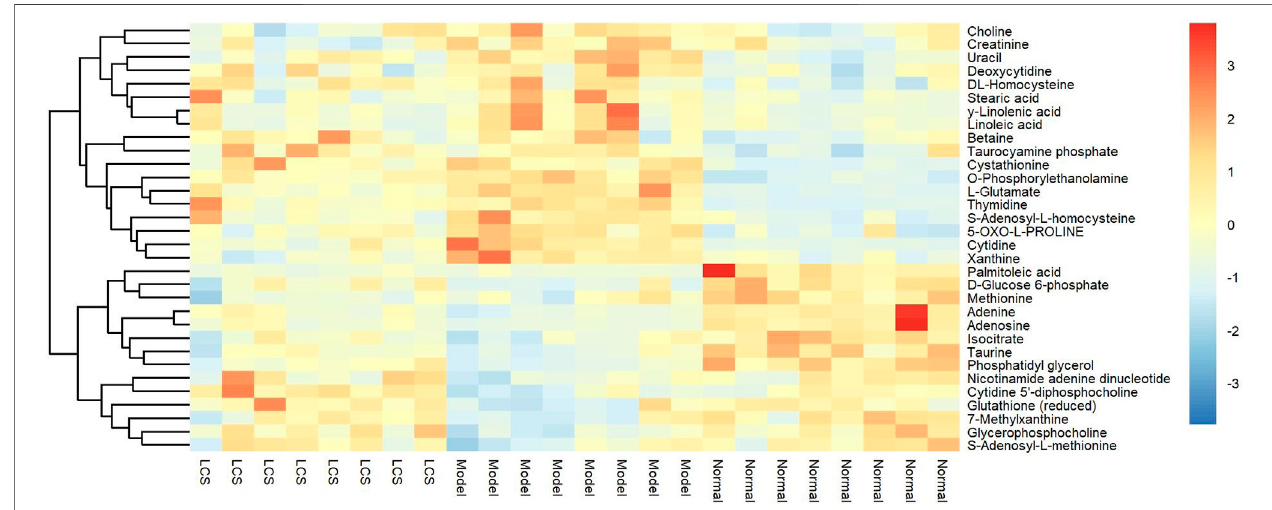
FIGURE 8 | Heat-map of the relative intensity of hepatic differential metabolites treated by LCS. Note: Red and blue indicate increased and decreased levels,